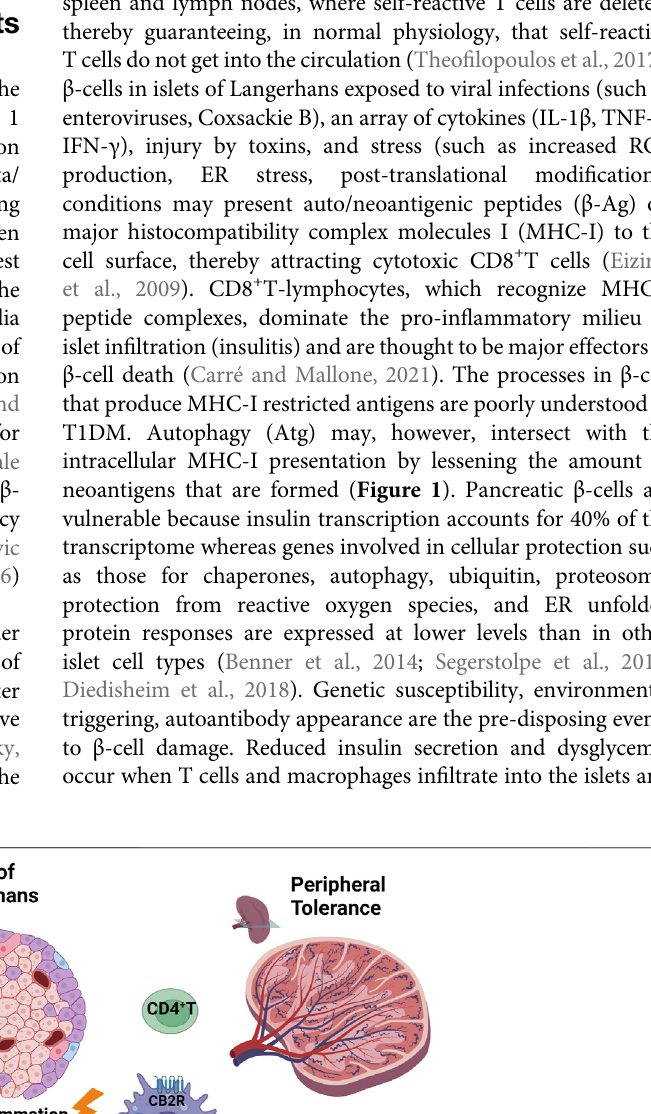
Frontiers in Pharmacology |